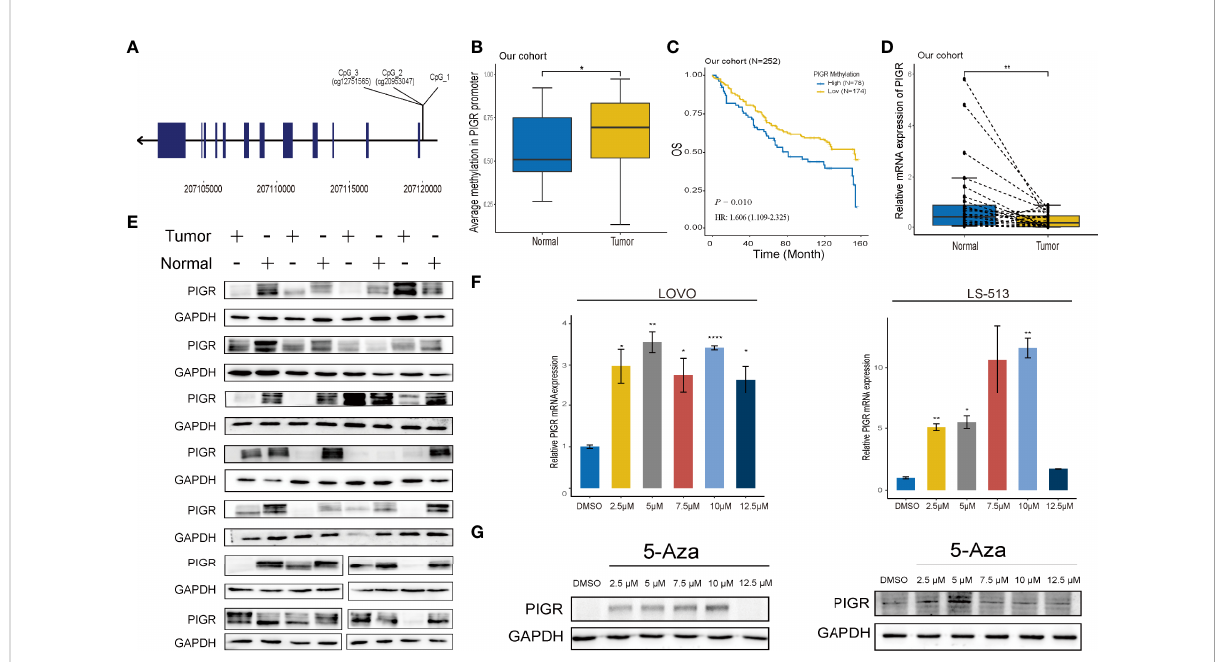
FIGURE 1 PIGRis downregulated and hypermethylated in CRC tissues and associated with CRC patients ’ survival (A) The positions of3 sequenced CpG in PIGR promoter. (B) The methylationof PIGR promoter in adjacent normal tissues (N = 27) and CRC tissues (N = 279)in our cohort. (C) Kaplan-Meier curve of OS based onthe methylationof PIGR promoter intumor tissues ofour cohort. (D) The relative PIGRmRNAexpressionin matched 28pairs ofCRC tissuesand adjacent normal tissues. (E) Westernblotof the PIGR expression in CRC tissues and matched adjacent normal tissues. Kaplan-Meiercurve of OSbased onthe methylation ofPIGRpromoter in tumortissuesof TCGA cohort. (F) The relative PIGR mRNA expression aftertreated with a series concentrationof 5-Azain LOVO andLS-513 cells (Differences compared to DMSOgroup) (n= 3; one-way ANOVA, P adjusted by FDR). (G) The PIGR protein expression aftertreated with a series concentration of5-Aza in LOVO and LS-513cells. * P < 0.05; ** P < 0.01, **** P <